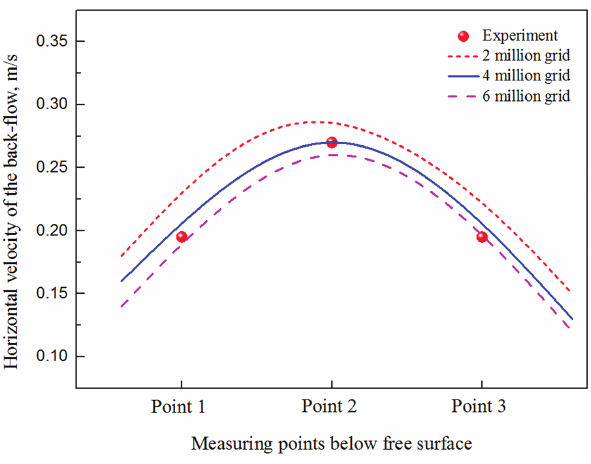
Figure 4: Variation of time-average horizontal velocities of the back- flow below free surface for different grid